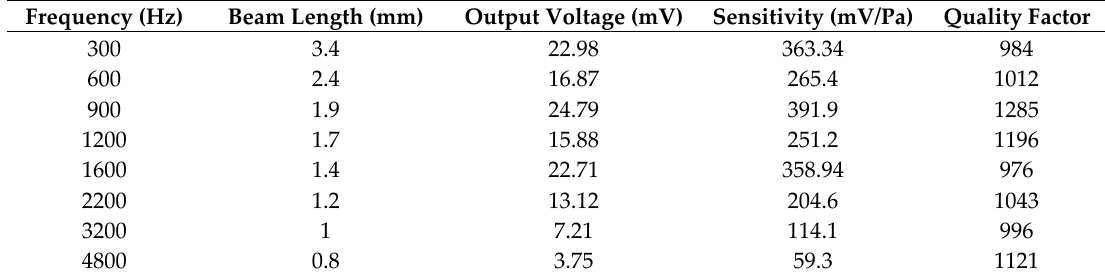
Figure 3. Frequency response of the transducers for all channels with a close-up view of channel 3. Table 1. Specifications of 8-channel structure.